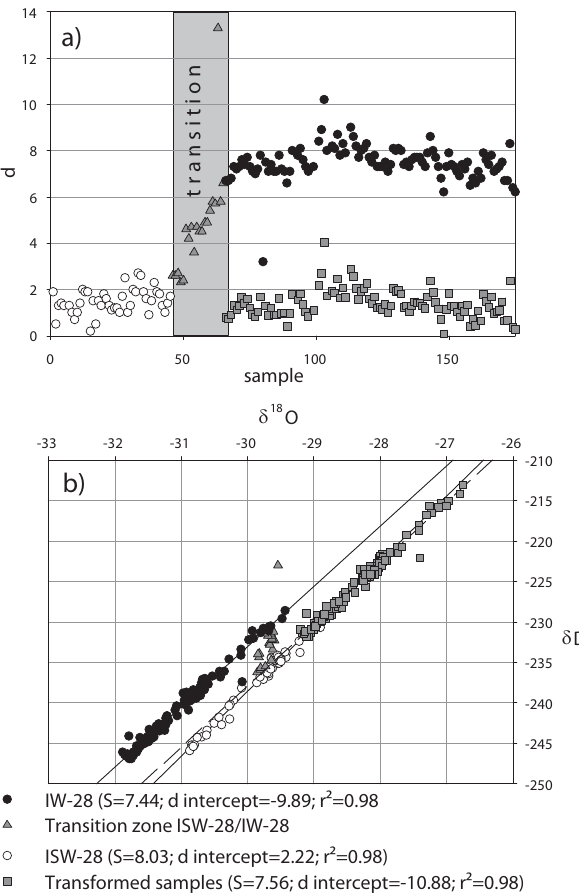
Fig. 9. d (a) and co-isotopic plots (b) of observed data for ISW- 28 (open circles) and IW-28 (black dots) compared to a simulation (grey squares) on the effect of hypothetical equilibrium refreezing of 10% of melted fraction in IW-28 sample, using Eq. (1). The re- frozen theoretical IW-28 samples reproduce the d of the ISW-28 samples and lie on the same co-isotopic line. They are however clearly offset towards less negative δ